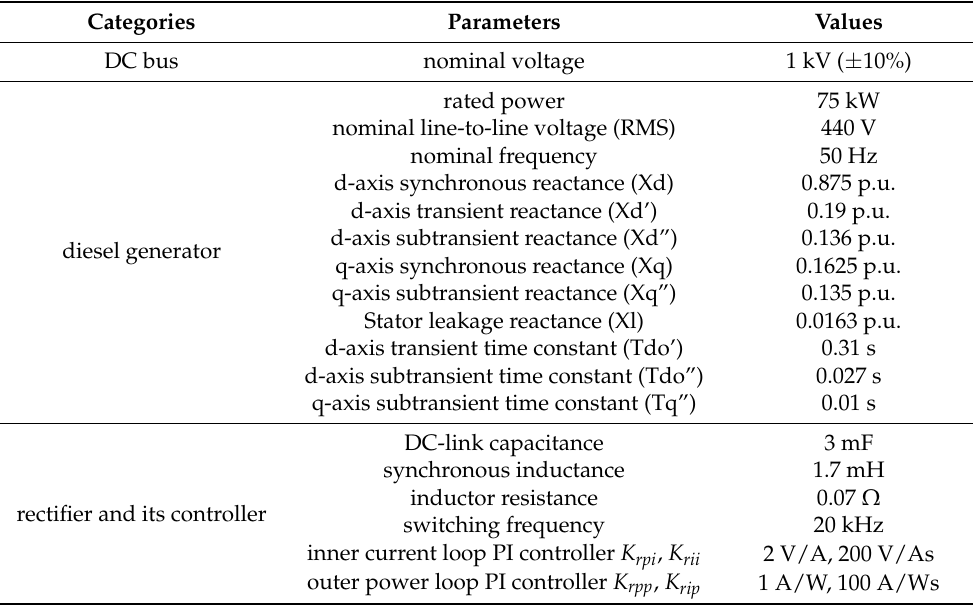
Table 2. Parameters of the studied DC SMG.